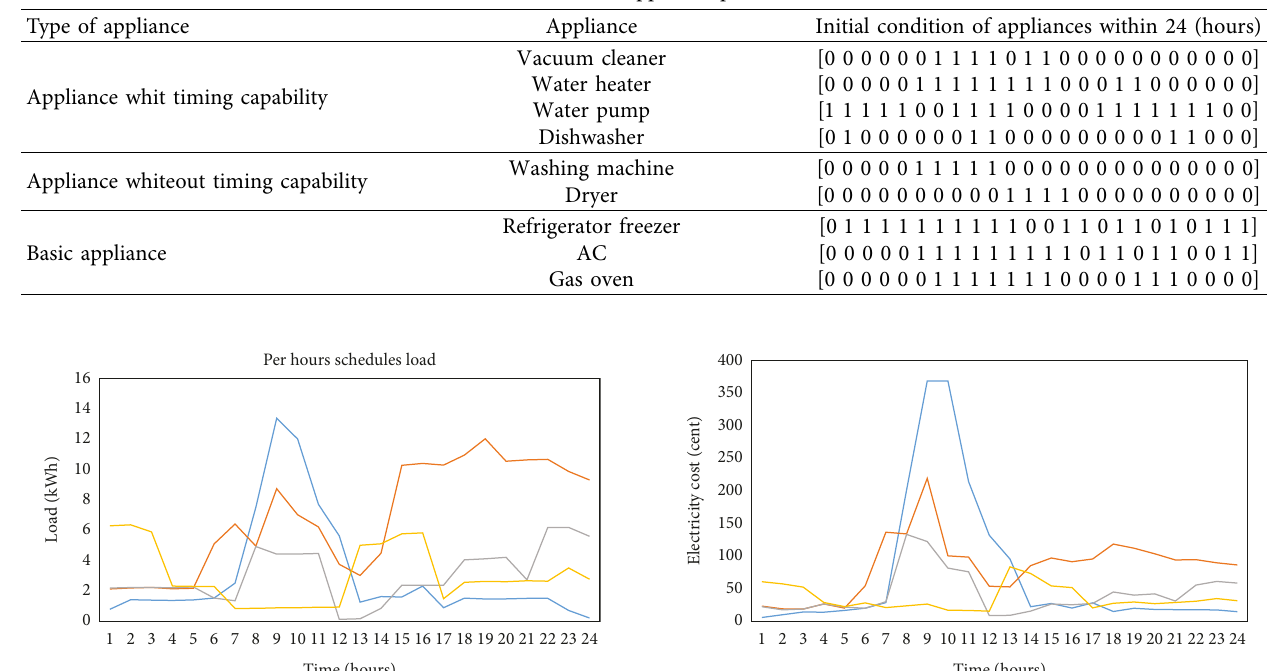
Table 2: Initial status of home appliance parameters (0 on − 1 off).